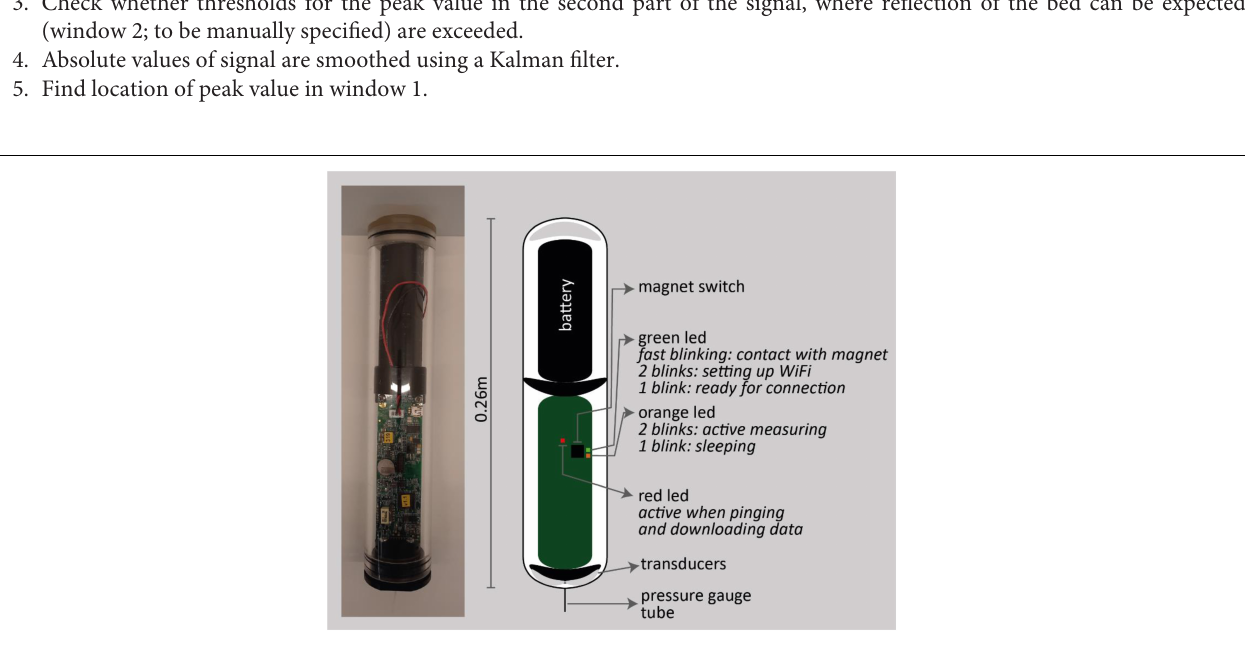
APPENDIX FIGURE A1 | Picture (left) and schematization (right) of A-SED